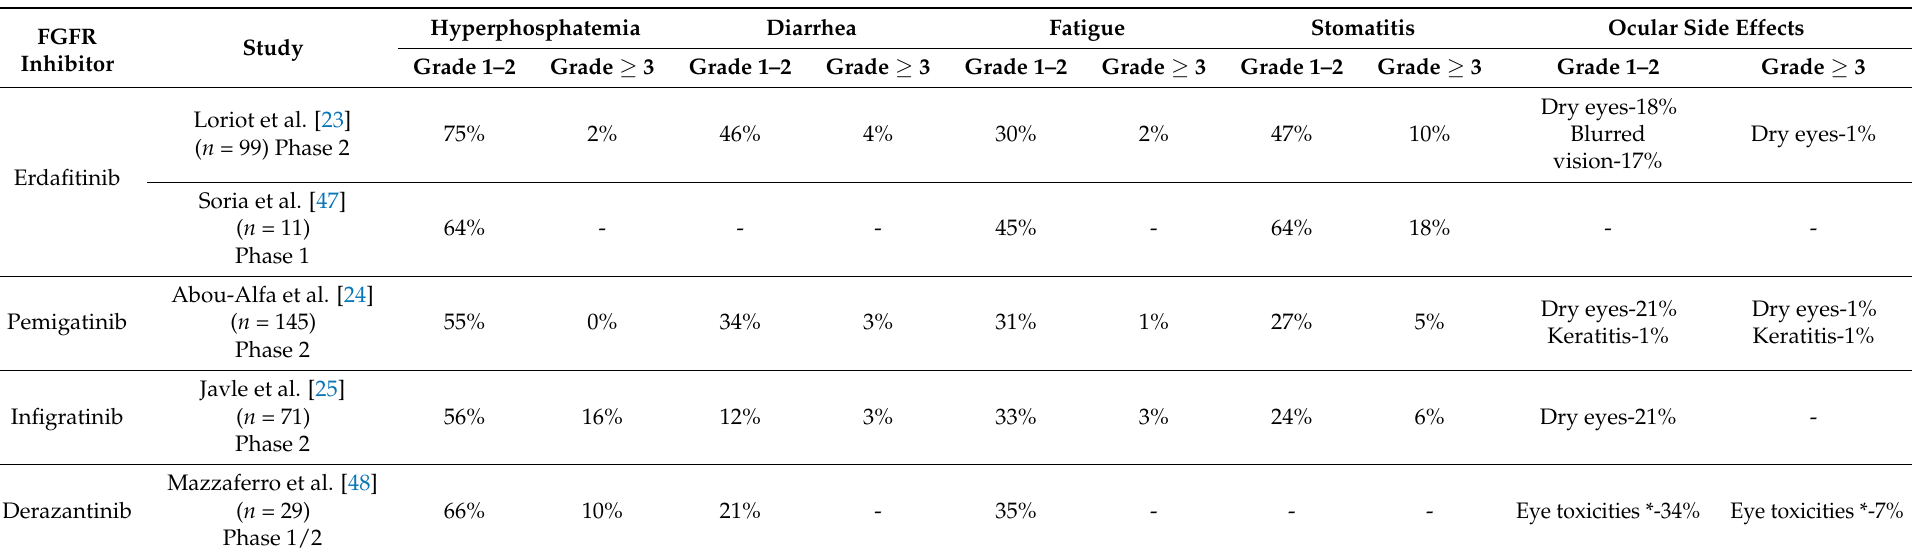
Table 3. Common adverse events observed in selected key clinical trials of FGFR